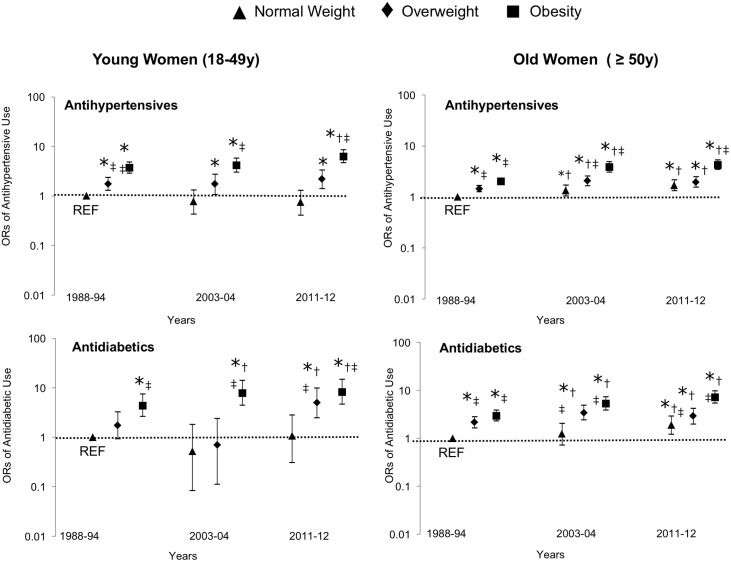
Odd ratios for prevalent antihypertensive and antidiabetics use in women by BMI, age and time.Both young and older women with obesity are more likely to be taking these medications over time, with the effect of time being significantly larger in older women. Models adjusted for ethnicity and education. Underweight sample was removed from the analyses. *: Significantly different from the reference group. †: Significantly different within the BMI category in 1988. ‡: Significantly different from the normal weight within the time period.